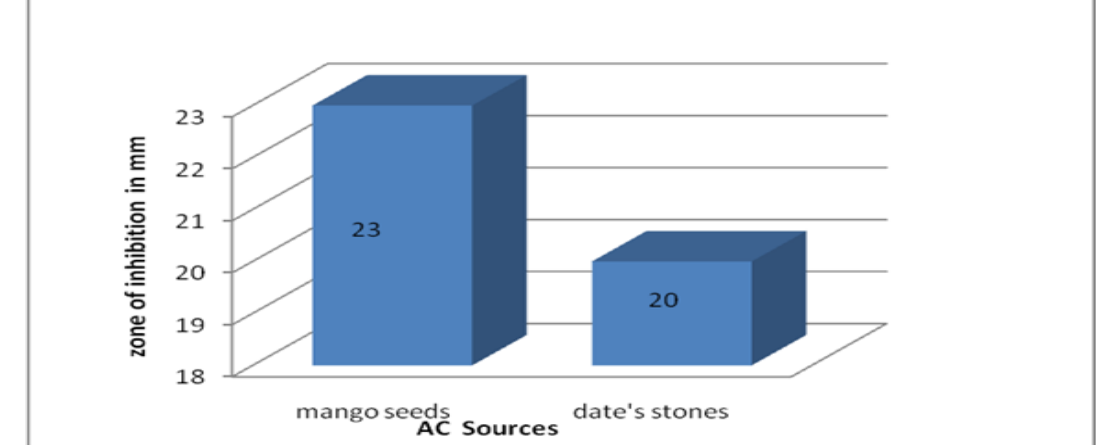
Figure 2. Showing that antibacterial activity of AC from mango seeds and date’s stones against Shigella spp